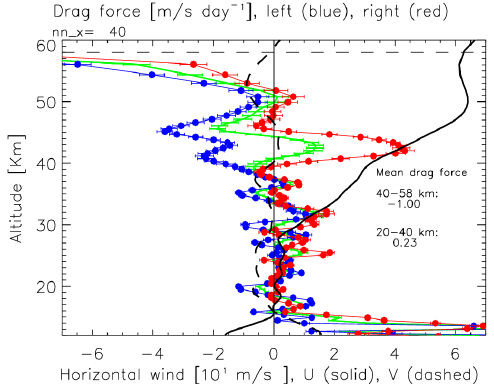
Figure 9. Spatial and temporal average of drag force vertical profile (ms − 1 day − 1 ) on the left side (blue), right side (red) and whole domain (green), within a square of ± 40 grid boxes (i.e. ± 120km on both x and y direction) from OHP, between 22:00 and 00:00UTC of 21 October 2012. Solid and dashed lines show vertical profiles of U and V wind components, respectively, in 10ms − 1 . Vertically averaged values of mean drag force are reported, in ms − 1 day − 1 . Error bars indicate the confidence level, with respect to the temporal